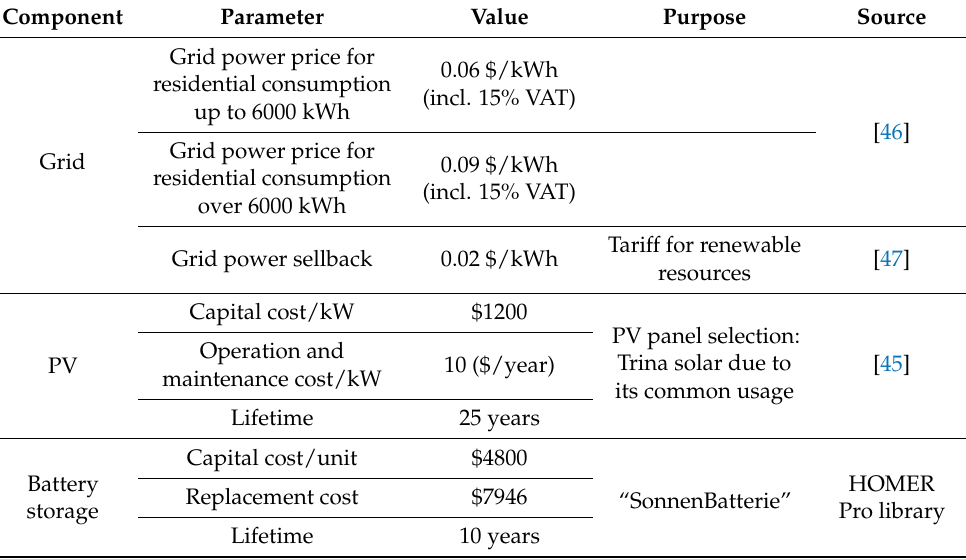
Table 2. Technical and economic data